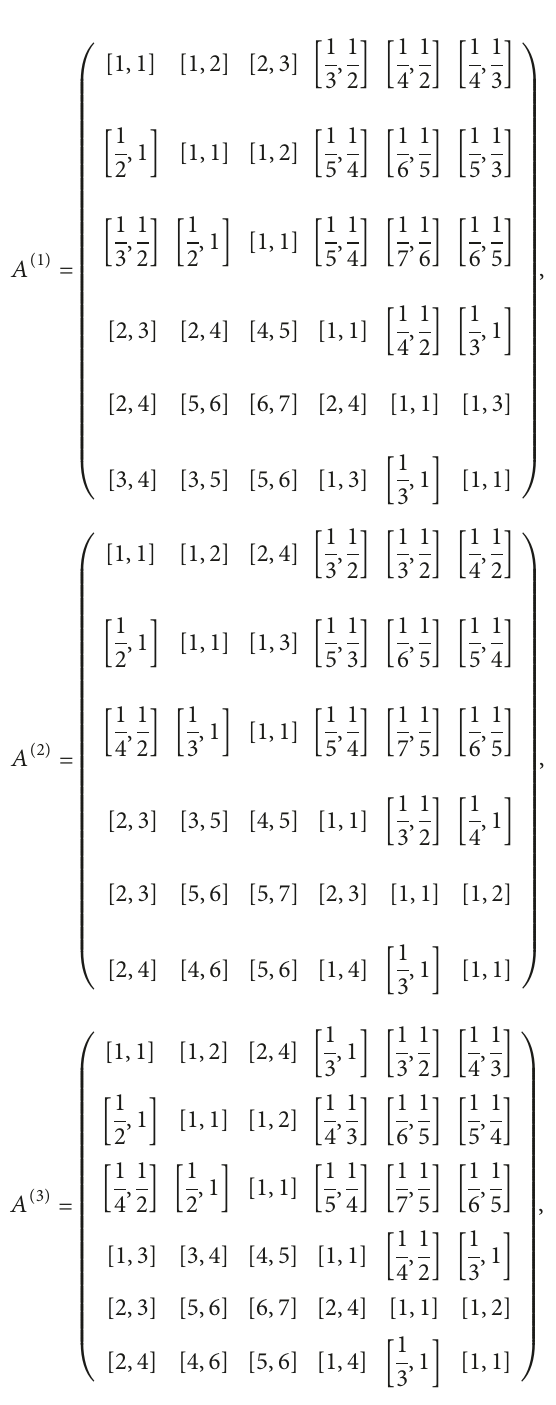
Figure 4: General arrangement diagram of main